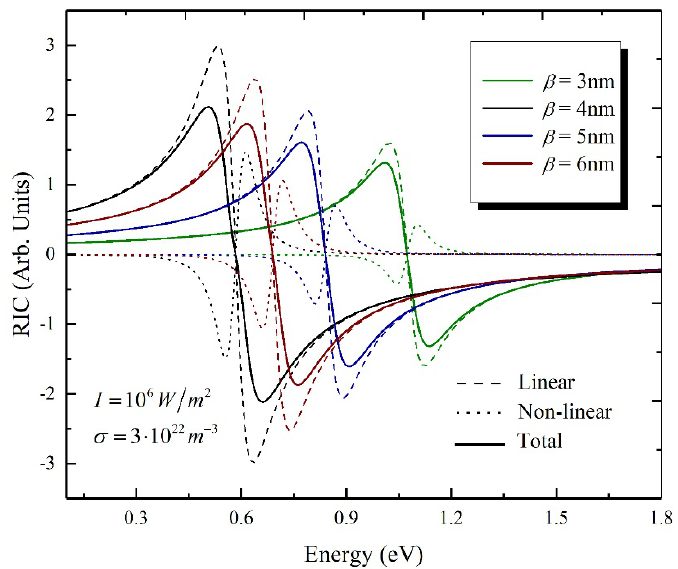
Figure 6. Dependence of linear, nonlinear and total values of the refractive index change on the energy of the incident light for four different values of β .